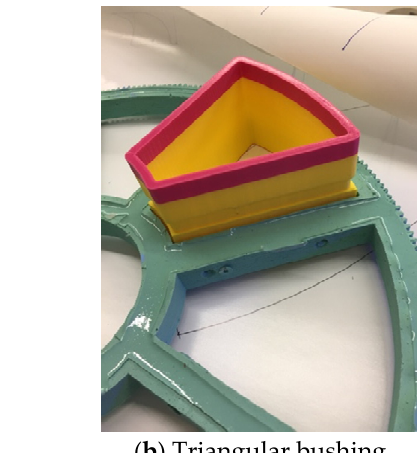
Figure 4. Plate designs, with round ( a ) and triangular ( b ) bushing.